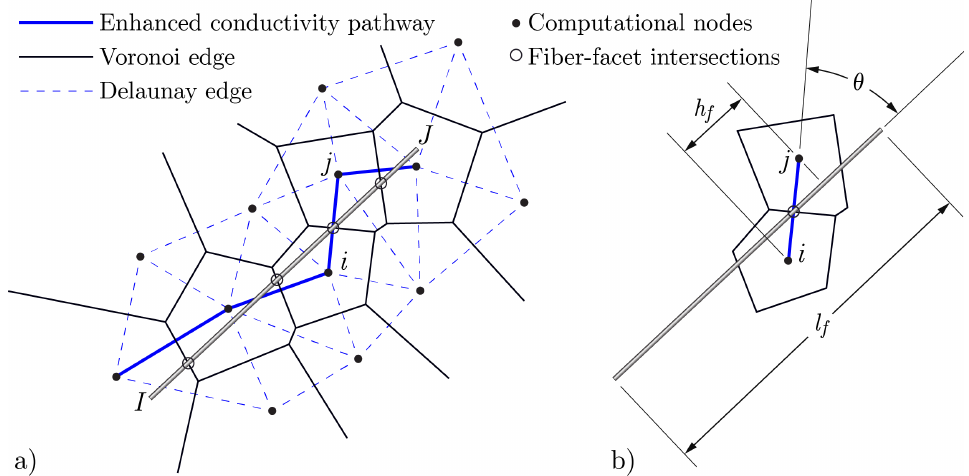
Figure 3. Semi-discrete representation of fiber IJ : ( a ) elemental pathway with enhanced conductivity; and ( b ) length h f used for conductivity calculations of element ij